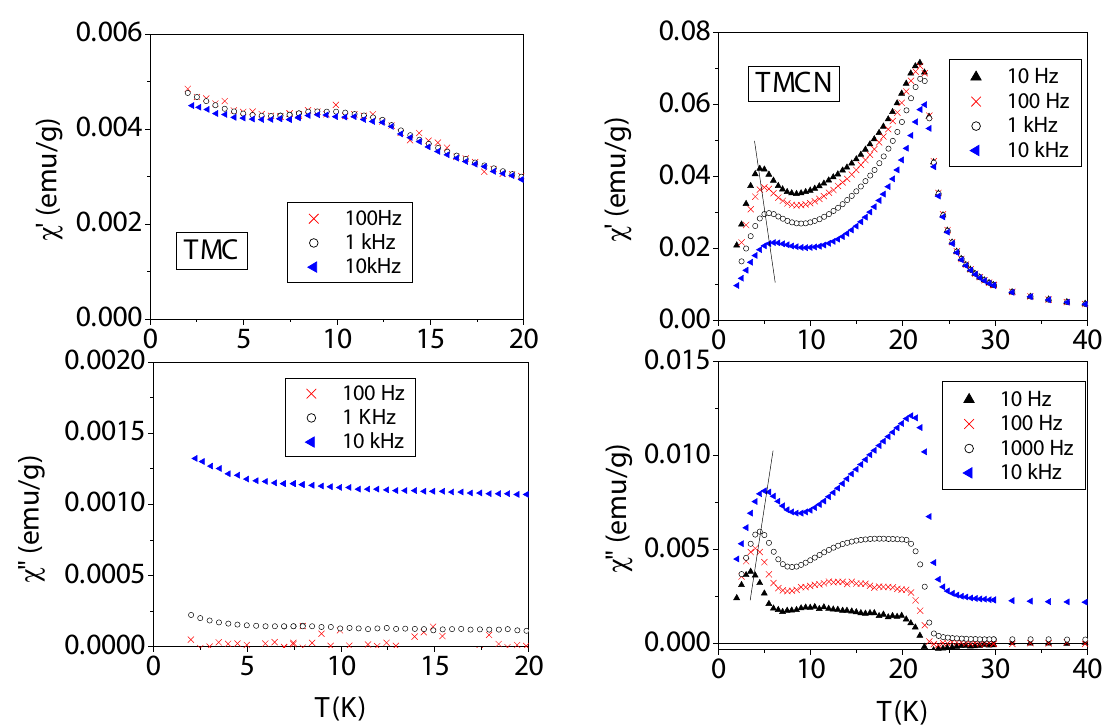
Figure 8. AC susceptibilities of a) TbMg to indicates the temperature shift versus frequency.